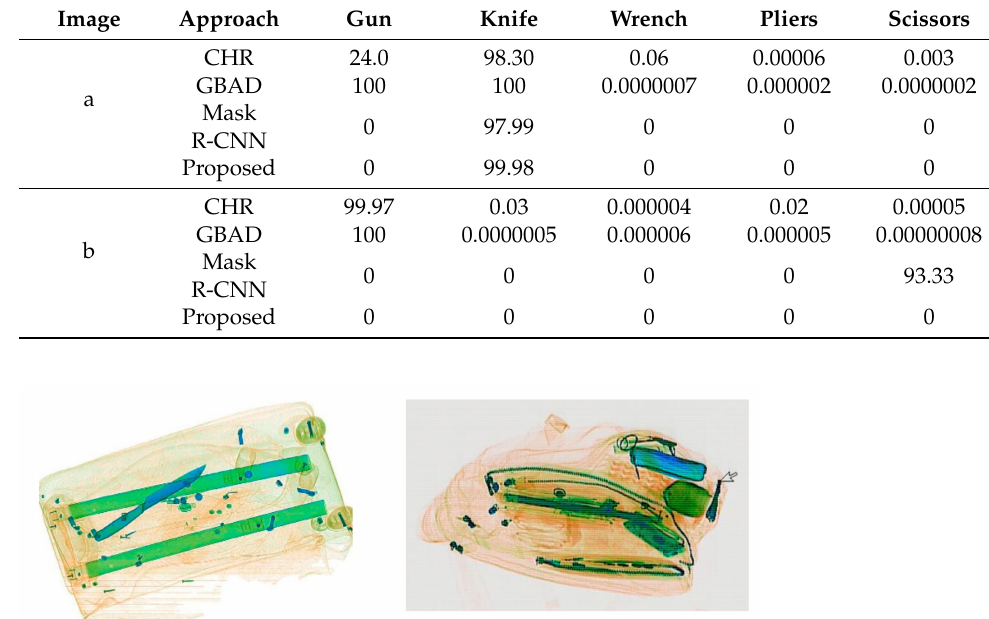
Table 7. Multi-label detection confidence (%) for randomly sampled images shown in Figure 8.